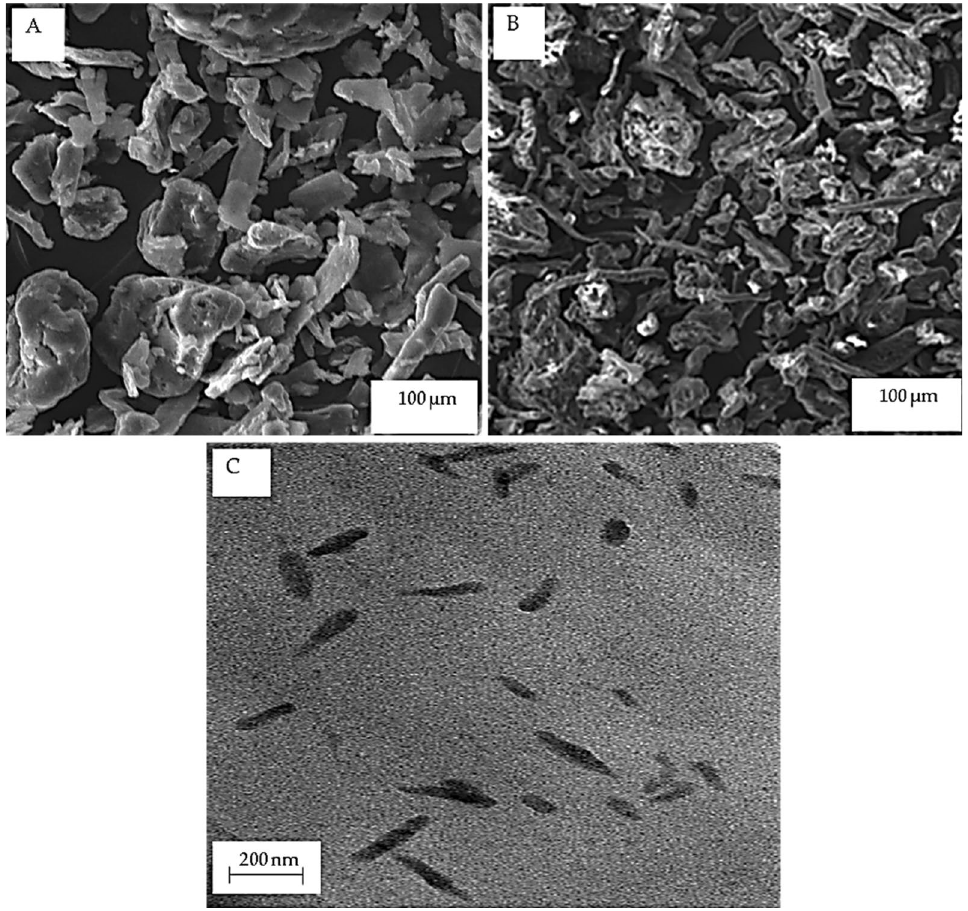
Figure 3. ( A ) SEM image of alkaline-pretreated corncobs ( B ) SEM image of corncobs cellulose ( C ) TEM image of prepared